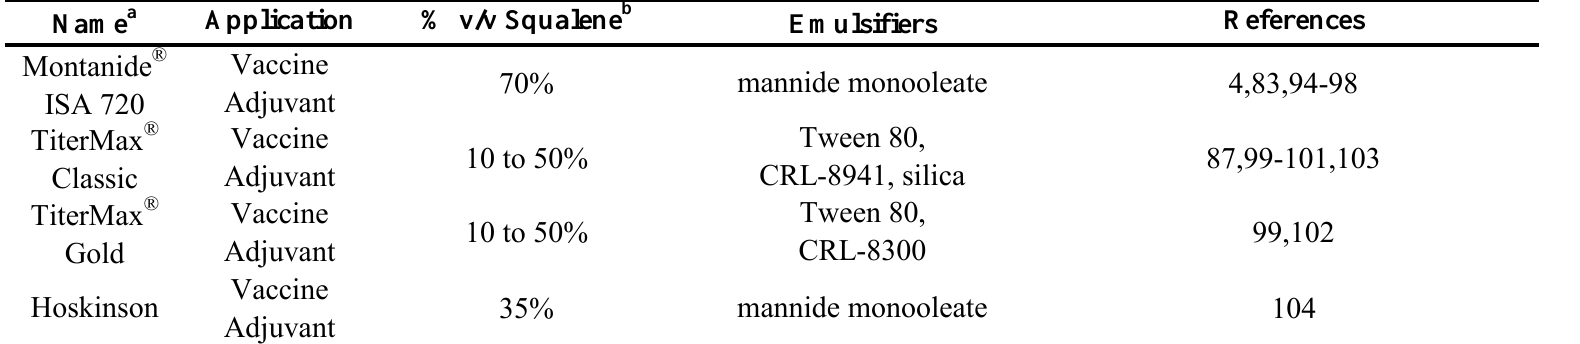
Table 4. Composition of squalene water-in-oil parenteral